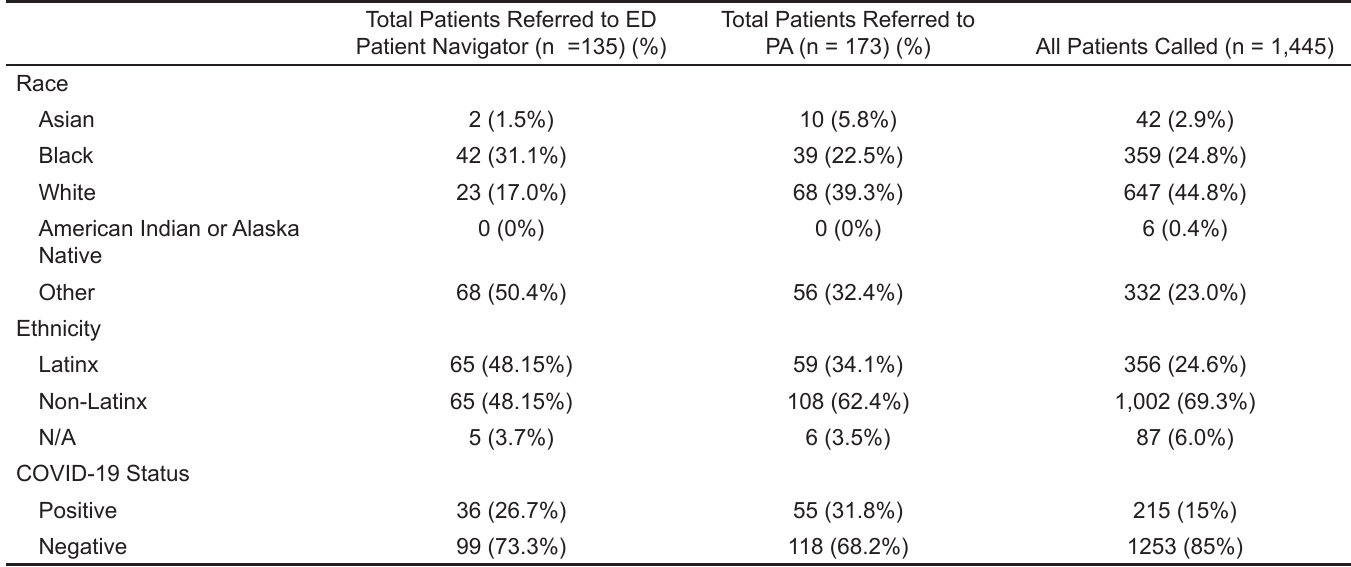
Table 3. Referrals and COVID-19 status by race and